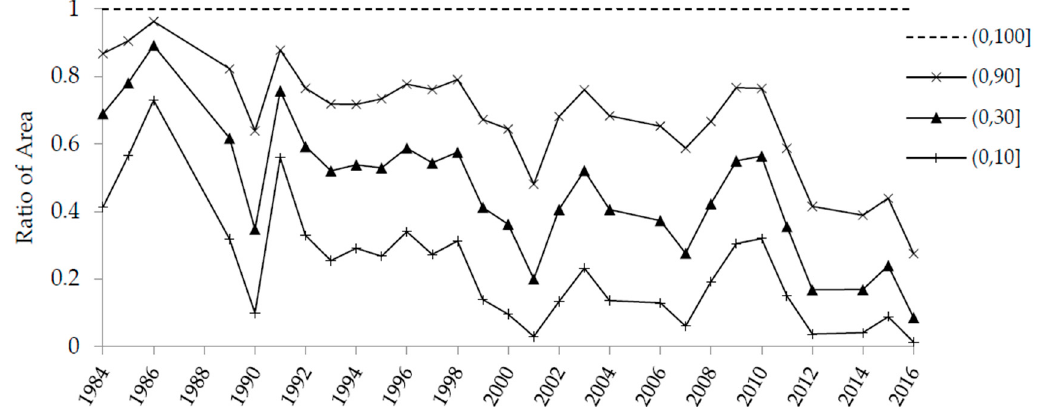
Figure 5. Area proportion changes of different foliage remaining ratio classes in 29 years.